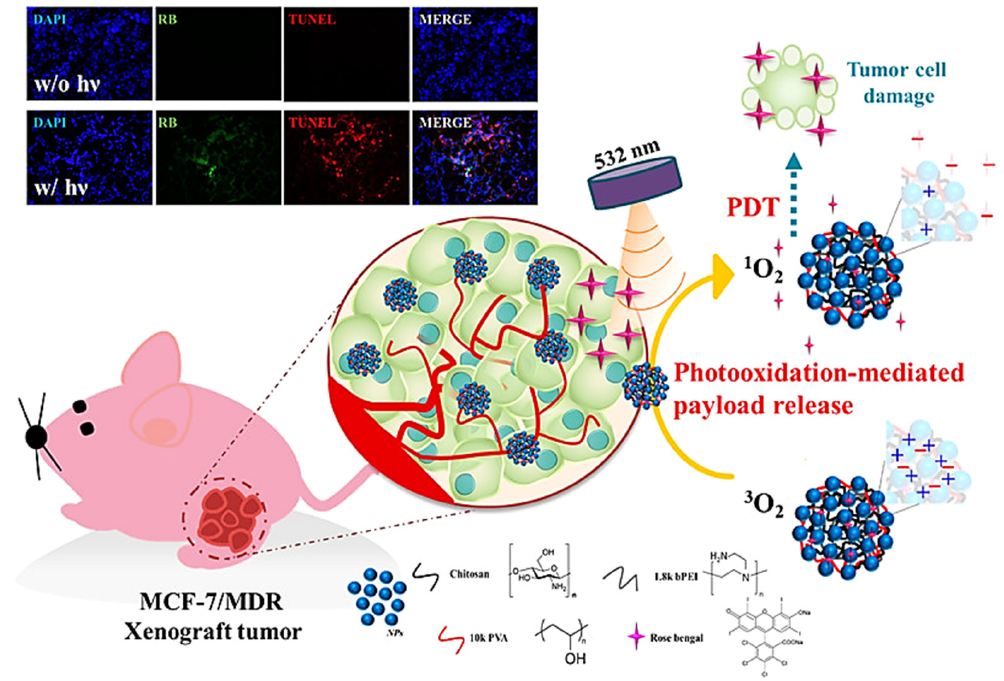
Figure 4. Encapsulation of Rose Bengal (RB) photosensitizer within chitosan/poly (vinyl alcohol) (PVA)/branched polyethylenimine (bPEI)/hydrophobic magnetic nanoparticles nanocomposites through electrostatic interaction provide a ROS-responsive photo-oxidation-responsive nanoplatform for controlled paclitaxel release and photodynamic therapy. Reproduced with permission from [64]. Copyright 2018. American Chemical Society.